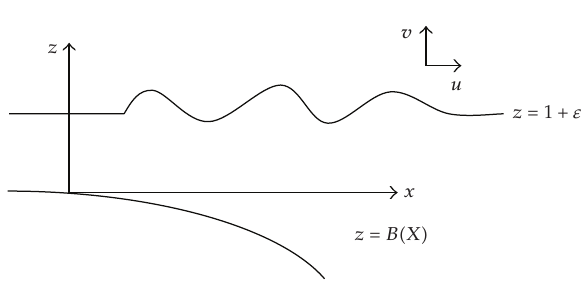
Figure 4: Wave propagation in stationary water over variable